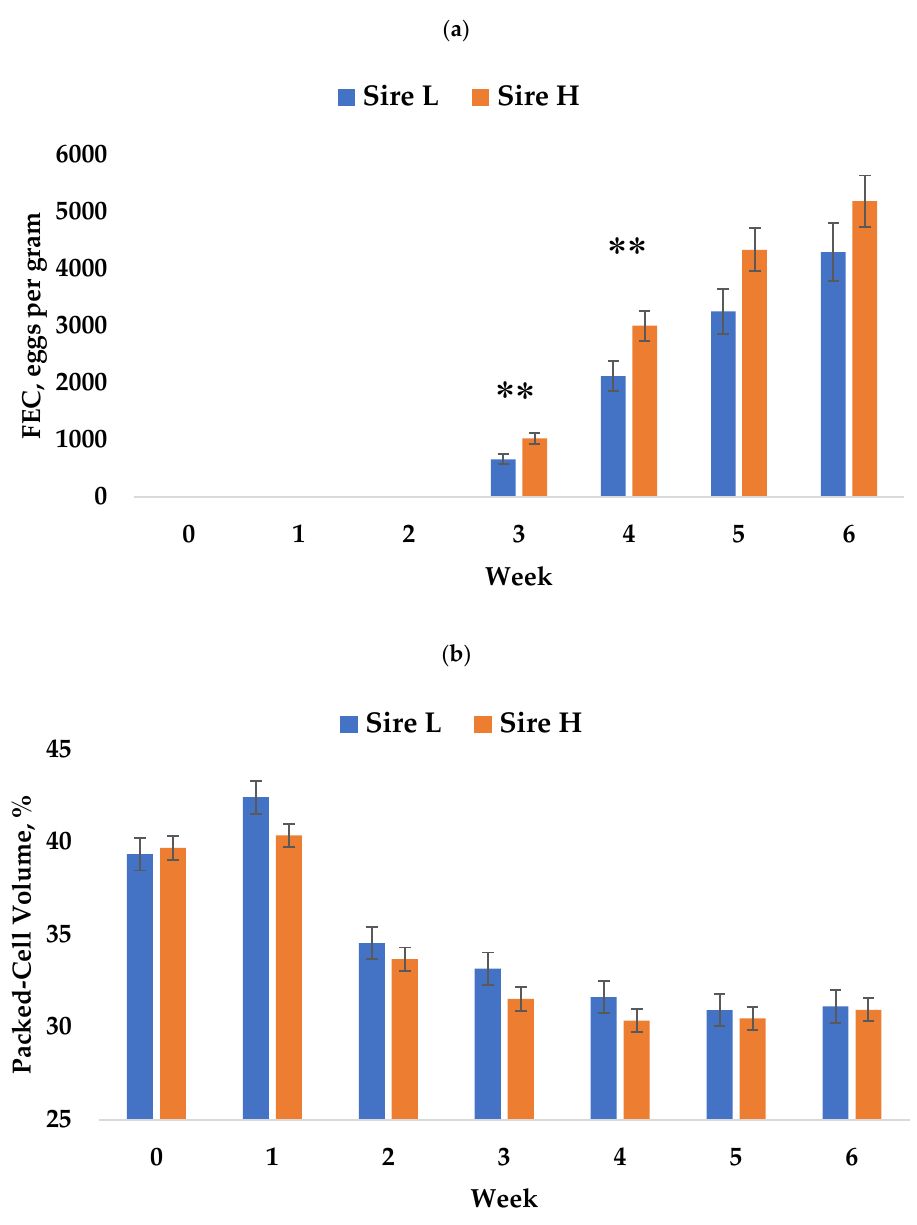
Figure 2. Effects of a H contortus infection on Rambouillet lambs. ( a ) Mean fecal egg count (FEC) for all lambs, and for each sire group, for weeks three, four, five, and six. At weeks one and two, FEC were zero. p -values for within-week sire comparisons for weeks three, four, five, and six were 0.0082, 0.0094, 0.0503, and 0.2160, respectively. ( b ) Mean packed-cell volume % (PCV) for all lambs, and for each sire group, across the trial.